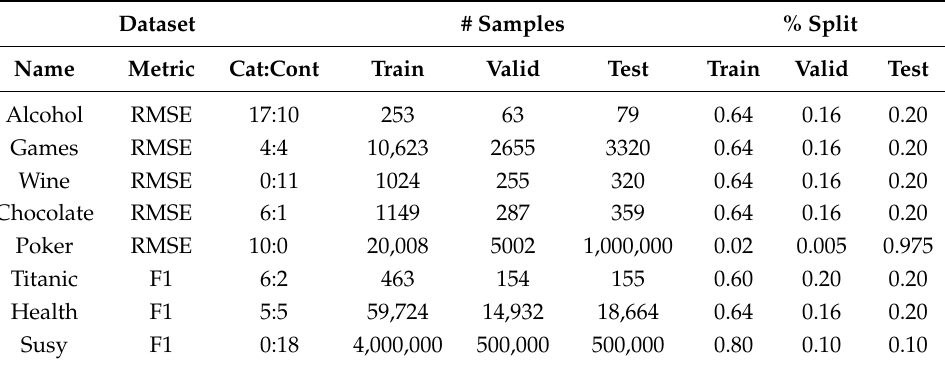
Table 1. Details of each dataset including evaluation metric, number and type of features, and train- validation-test split. Cat refers to Categorical, Cont refers to Continuous in regards to the feature type present in the datasets. Dataset # Samples %